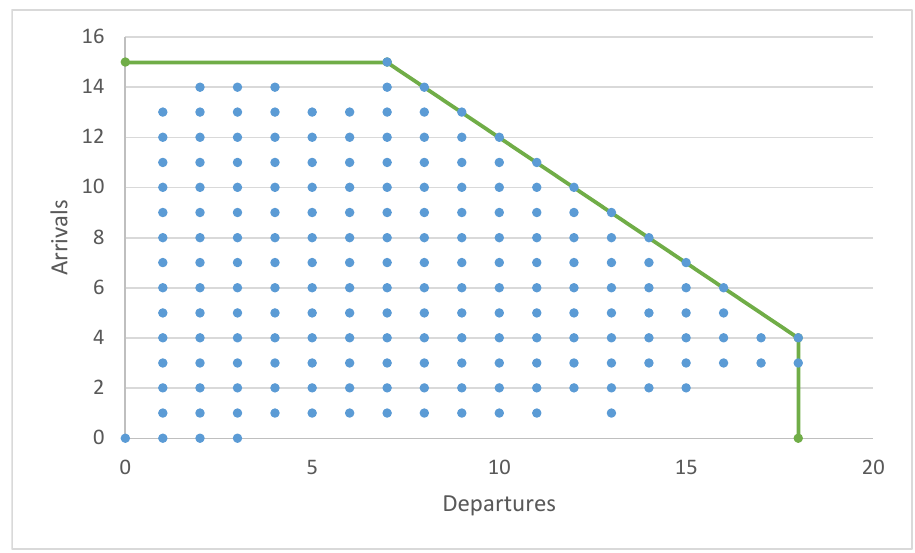
Figure 6. The envelope of Pareto frontier for I_05_27 clones from CL00 to CL50.